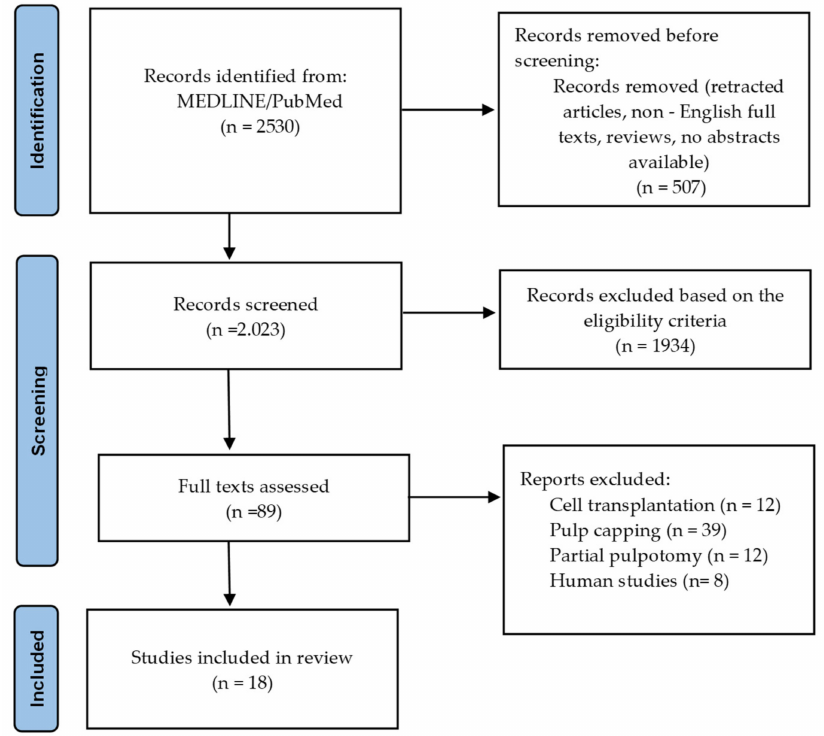
Figure 1. PRISMA flow